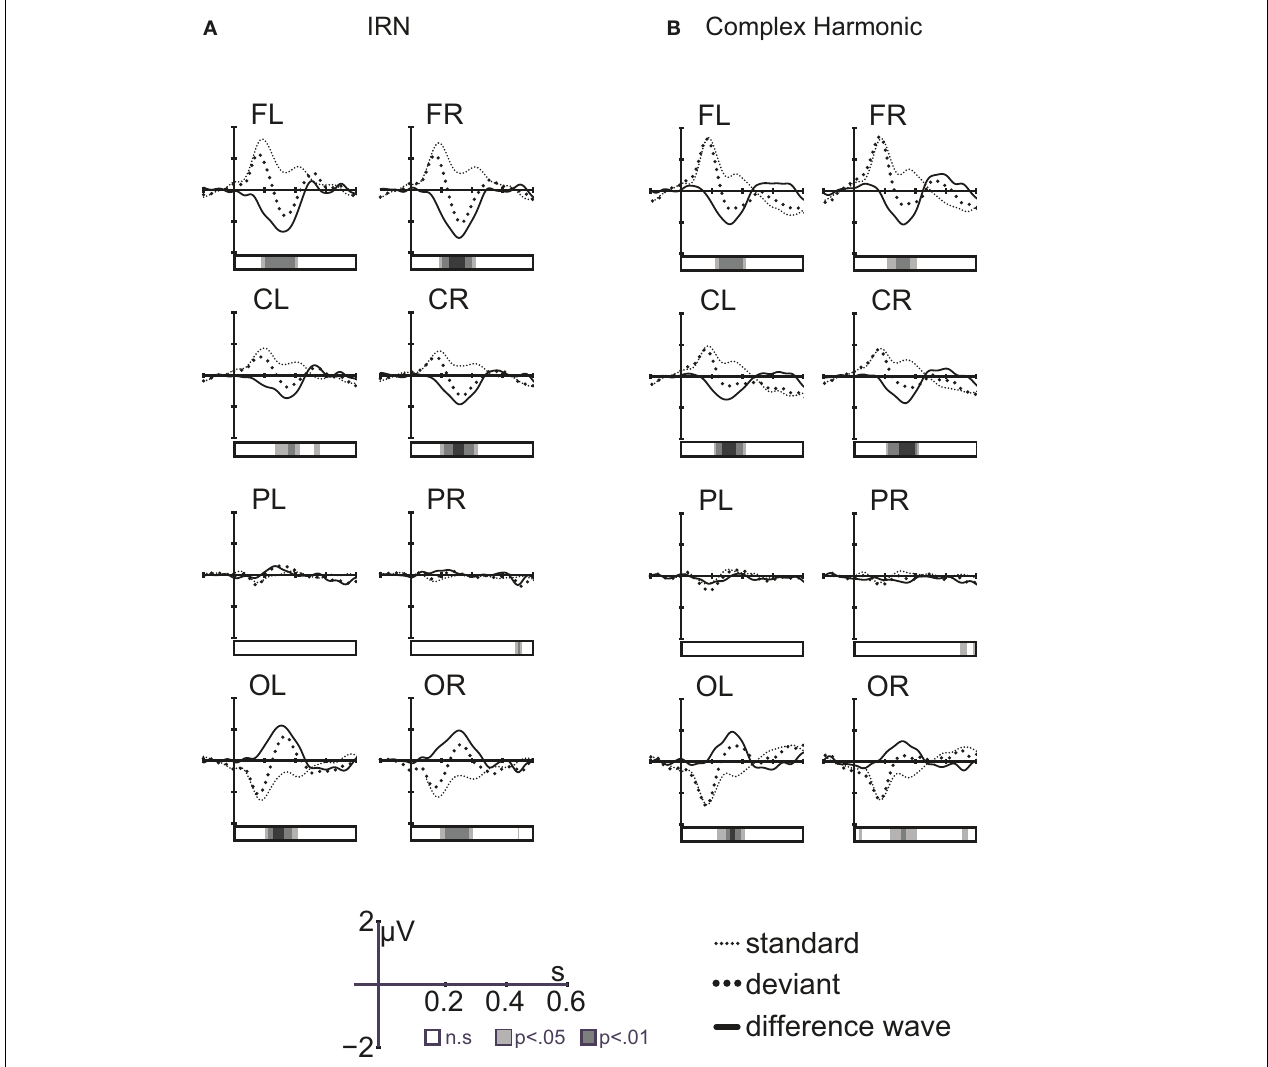
FIGURE 5 | Grand average waveforms [standard response, deviant response, and difference wave (deviant-standard)] for IRN stimuli (A) and complex harmonic stimuli (B). The bars under the waveforms show latencies at which the amplitude of the difference wave was significantly different from zero.